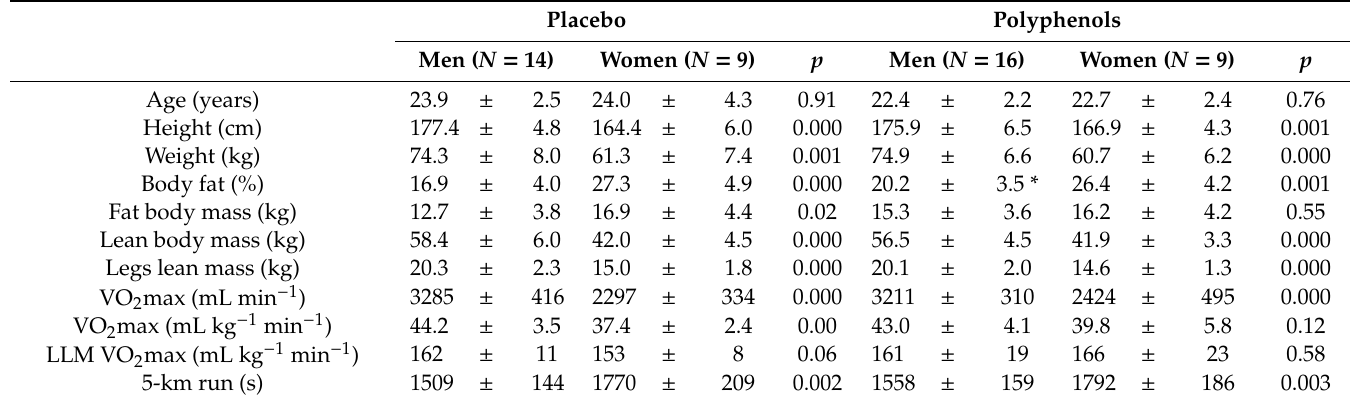
Table 3. Physical characteristics, body composition, VO 2 max and 5 km running